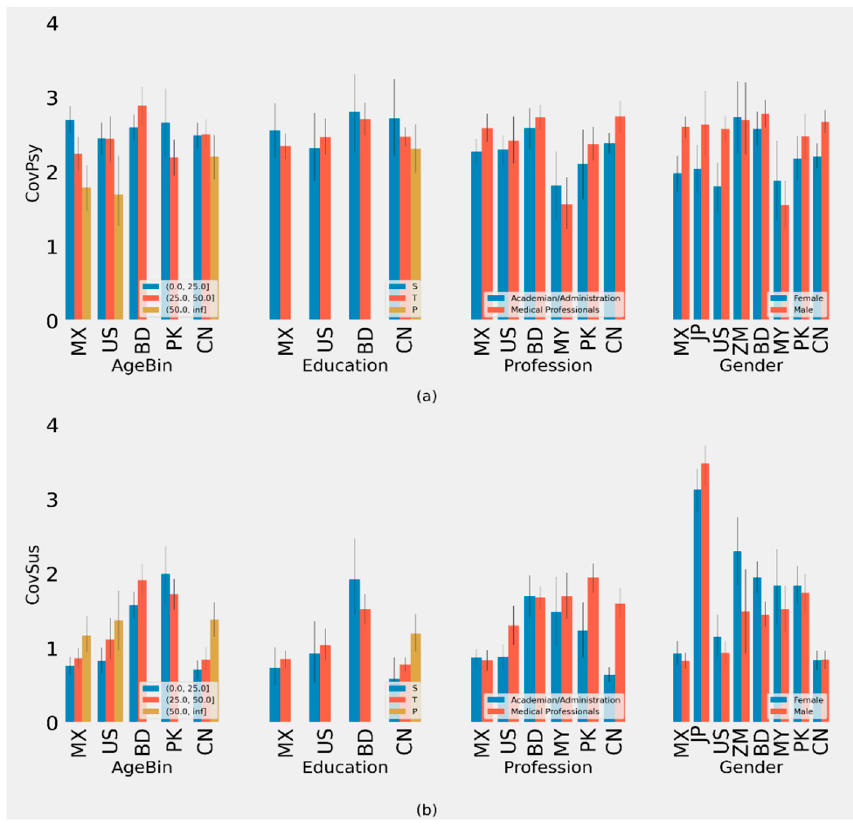
Figure 3. ( a ) Plot of Average CovSus metric of different groups with 90% CI ( b ) Plot of Average CovBh of different groups with 90% CI. (ISO-2 Codes for countries are used).